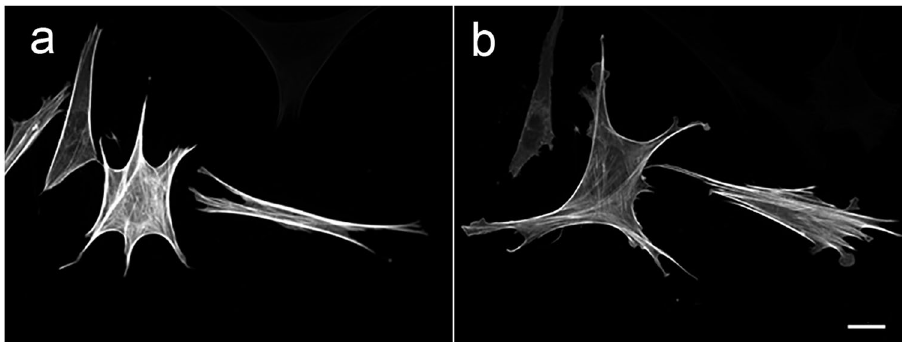
Fig. 4 Stress fi ber remodeling in MSCs exposed to simulated microgravity as analyzed by confocal fl uorescence microscopy. MSCs expressing Lifeact-TagGFP2 contained thick stress fi bers under 1 G conditions ( a ), whereas an exposure to simulated microgravity for 6 h led to the appearance of thinner stress fi bers ( b ). The images in ( a ) and ( b ) showing the same fi eld of view, were recorded, processed and presented in an identical condition (Kobayashi, unpublished). Scale bar: 20 μ